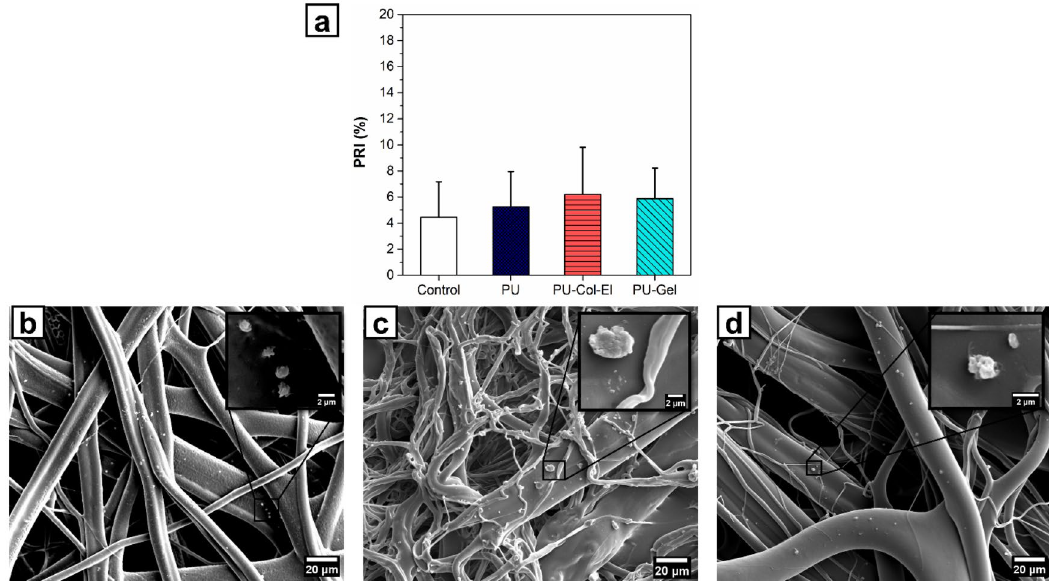
Figure 7. ( a ) Platelet retention index (PRI) of the scaffolds, and platelet adhesion onto ( b ) PU, ( c ) PU-Col-El, and ( d ) PU-Gel